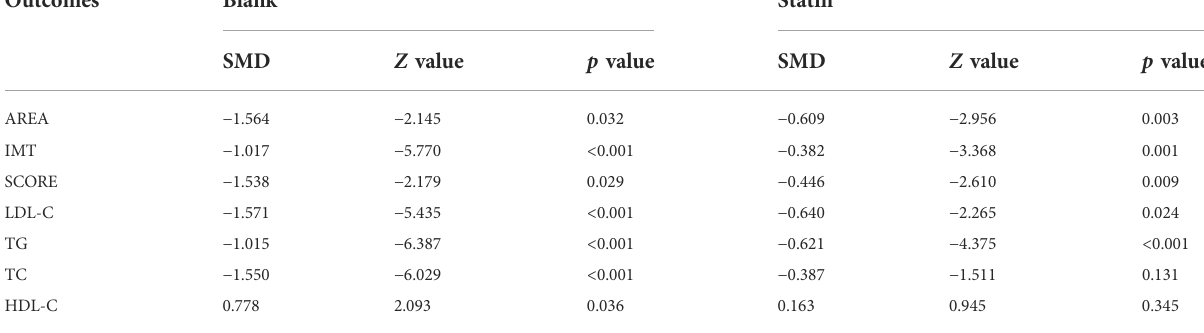
TABLE 8 Subgroup analysis strati fi ed by control setting.